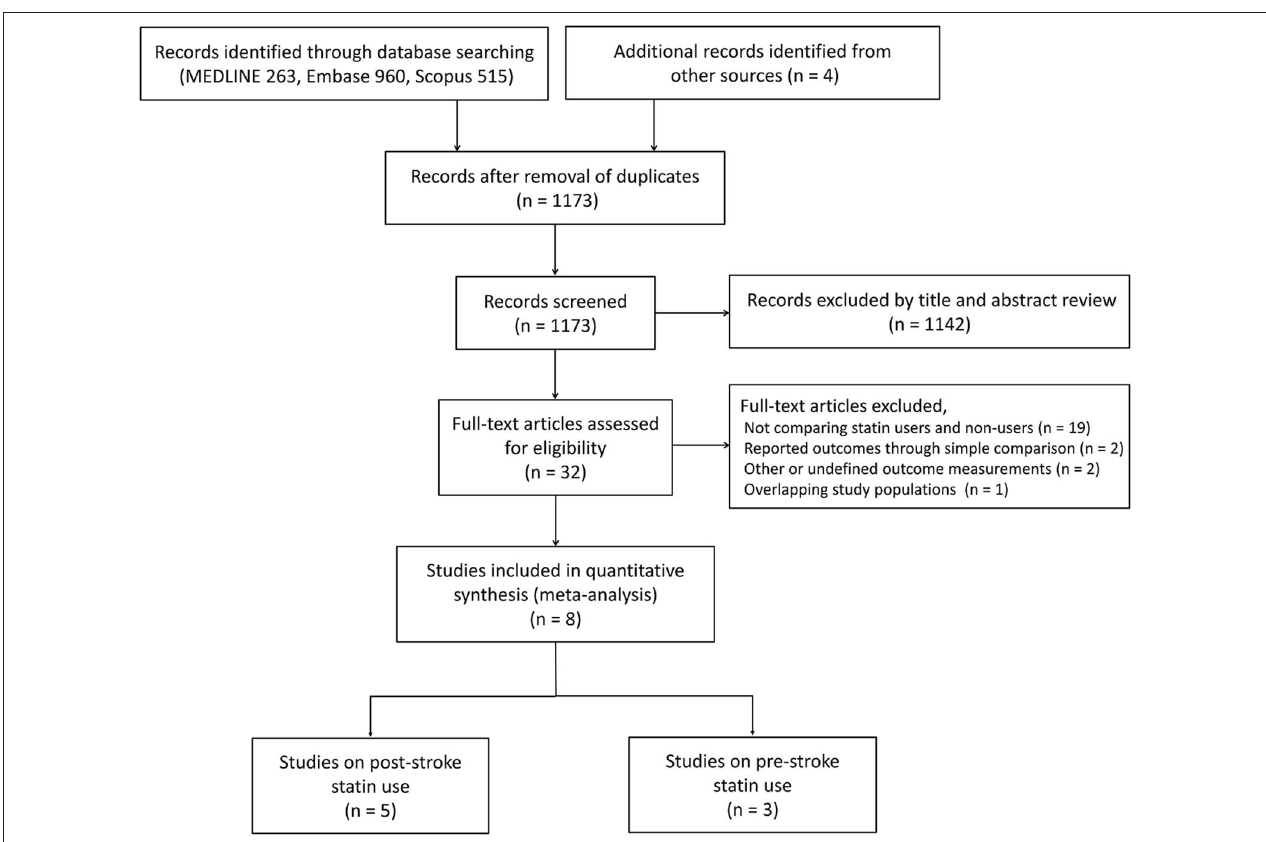
FIGURE 1 | PRISMA flow